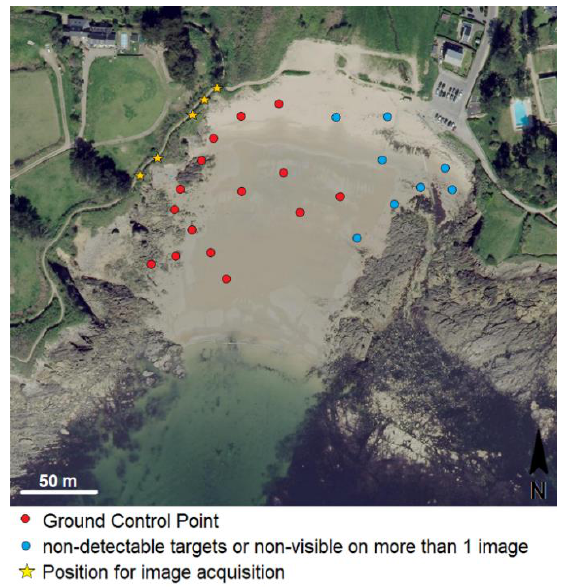
Figure 5. Configuration of the Porsmilin Beach survey by smartphone Structure-from-Motion (SfM) photogrammetry, using the Galaxy S7 ® (Background image: BD Ortho — IGN© ).